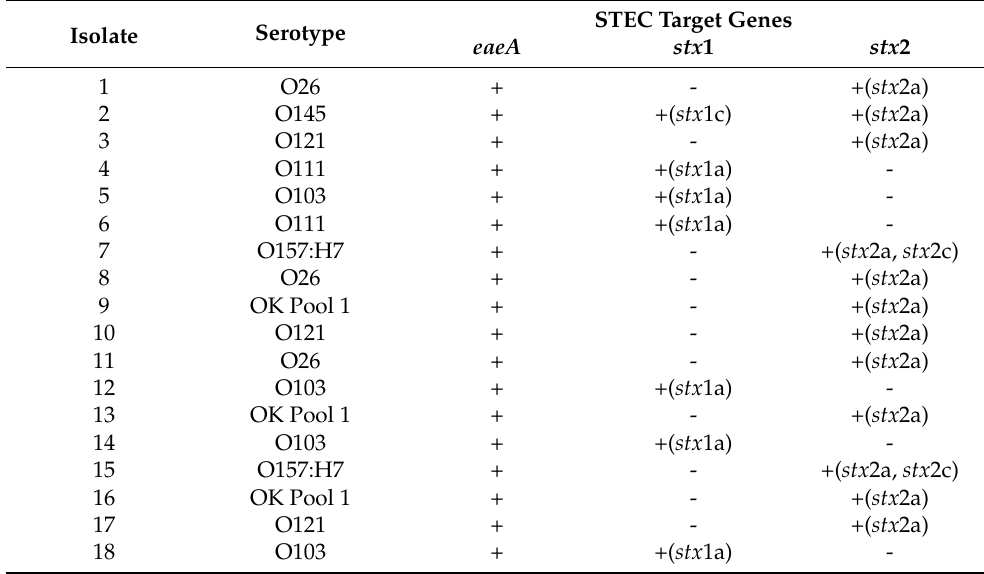
Table 3. Serotypes and virulence profile of isolated STEC in analyzed feed samples in a nine-year period (December 2012–November